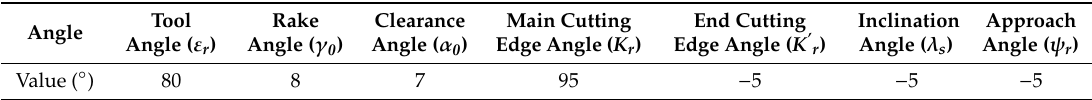
Figure 2. Micrograph of material matrix microstructure.